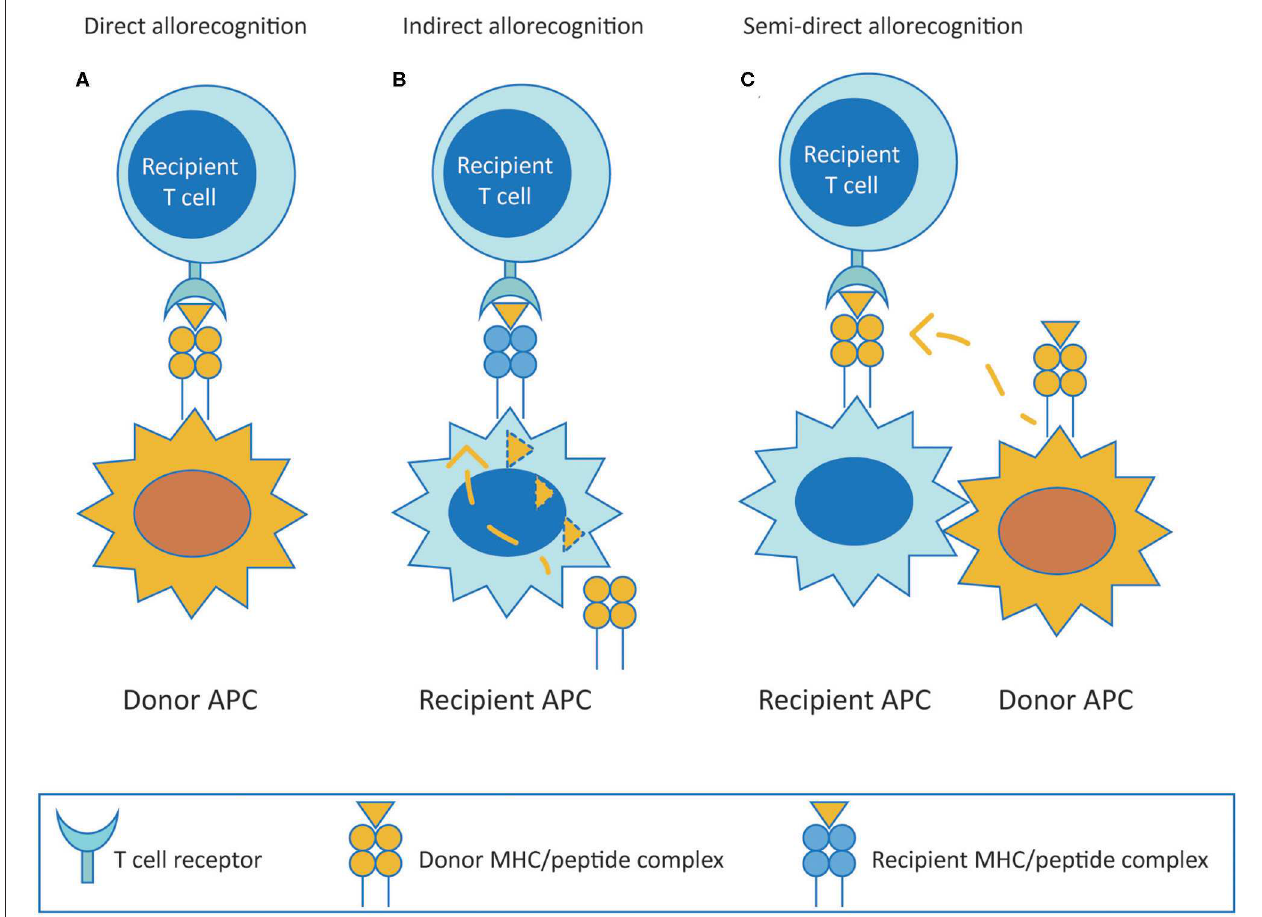
FIGURE 1 | T cell allorecognition pathways. (A) (Direct pathway) Recipient T cells recognize intact donor alloantigens on the surface of donor APC. (B) (Indirect pathway) Recipient T cells recognize processed donor allogeneic peptides presented on the context of self MHC antigen by recipient APC. (C) (Semi-direct